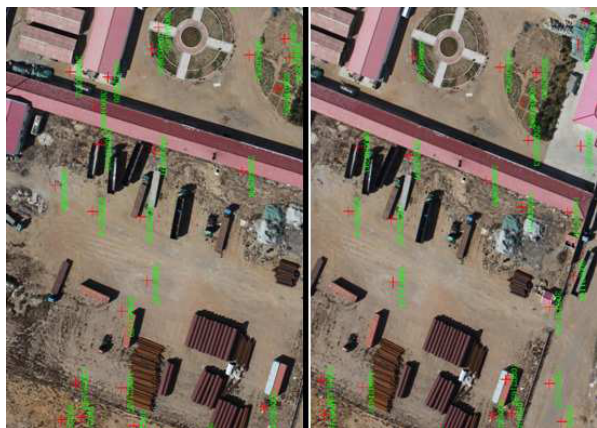
Figure 2. The distribution of corresponding points of the stereo pair at the middle of a strip in the second experiment.